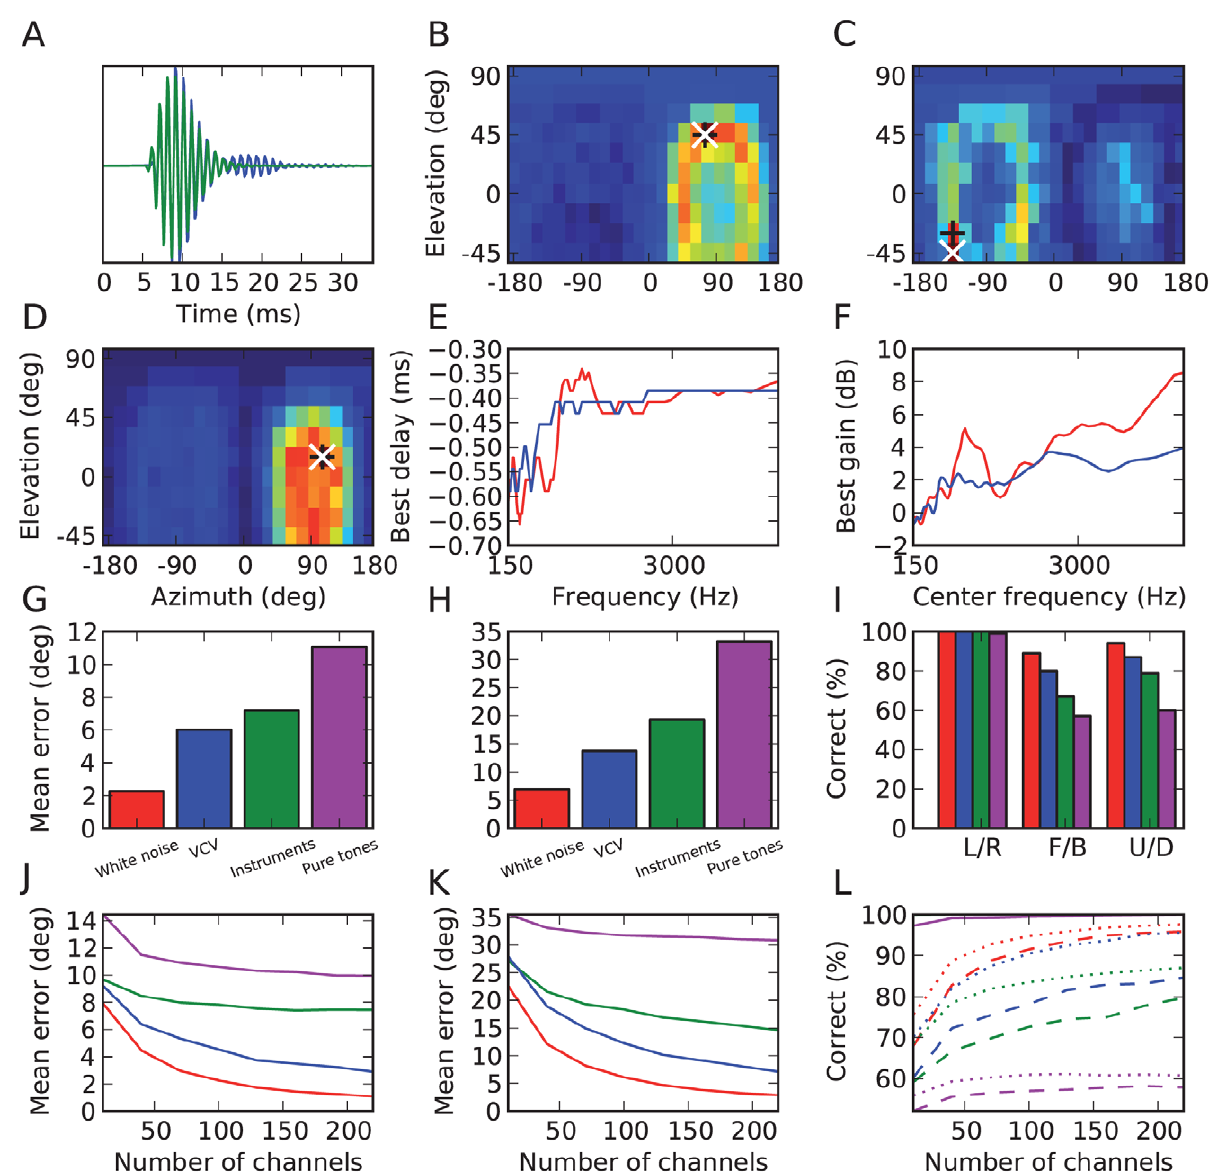
Figure 8. Estimation results in the approximate model. (A) Comparison of a gammatone-filtered HRIR (blue) and an approximate filter (green; gammatone with best delay and gain). (B, C) Activation of neural assemblies for two particular source locations, as in Figure 6. (C) shows a mistake of the model. (D) Spatial receptive field of a particular neural assembly, as in Figure 6. (E) Preferred interaural delay vs. preferred frequency for neurons in two assemblies tuned to locations differing only by a front-back reversion. (F) Interaural gain difference vs. preferred frequency for the same assemblies. (G–I) Performance of the model, as in Figure 6. (J–L) Estimation results as a function of the number of frequency channels used. Simulations were all performed using 240 channels. To obtain estimates of the error using a smaller number of channels while keeping the same frequency range, a randomly chosen subset of the 240 channels was chosen. Error estimates are averaged over many such random choices. (J) Mean error in azimuth estimates for white noise (red), vowel-consonant-vowel sounds (blue), instruments (green) and pure tones (magenta). (K) Mean error in elevation estimates. (L) Categorization performance discriminating left and right (solid), front and back (dashed) and up and down (dotted). For all classes of sounds except the pure tones, the left/right categorization performance is 100% for all